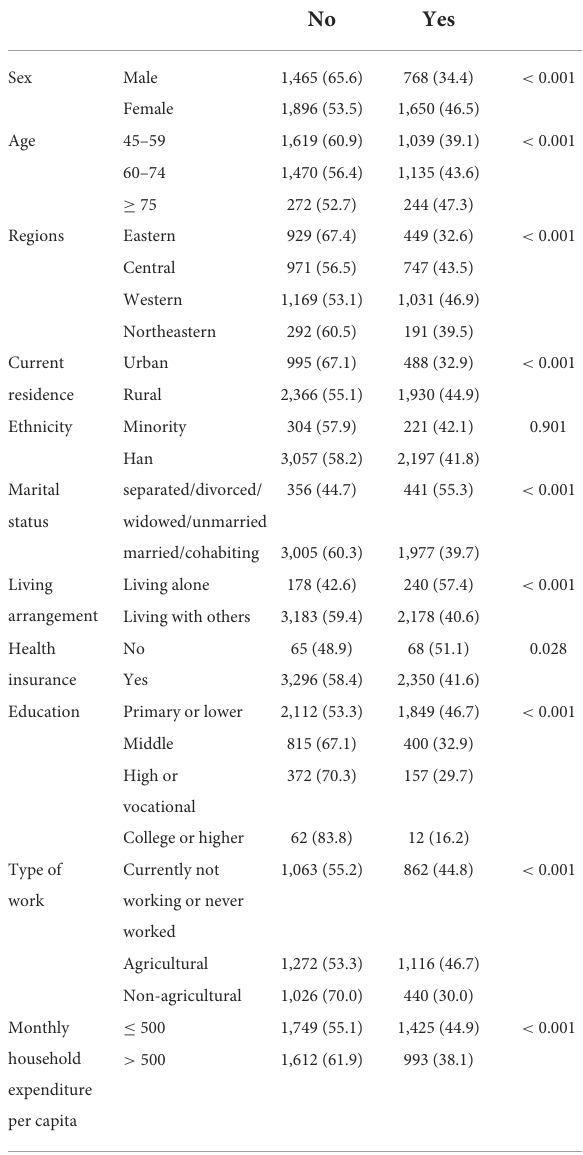
TABLE 1 Sociodemographic characteristics of the LBP population by the presence of depressive symptoms ( n = 5,779). Variable Depressive